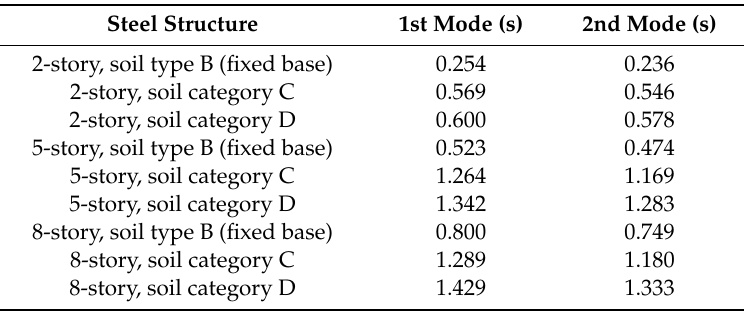
Table 3. Modal periods of buildings under